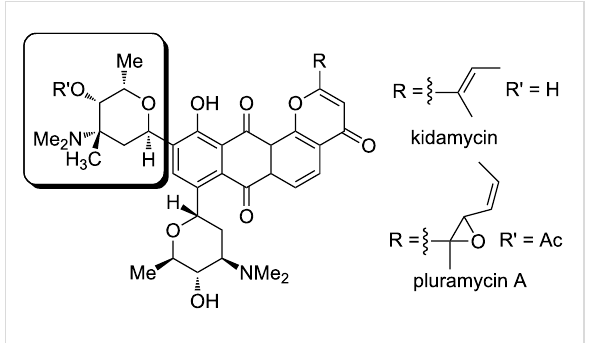
Figure 1: N , N -Dimethyl-L-vancosamine as substructure of kidamycin and pluramycin.